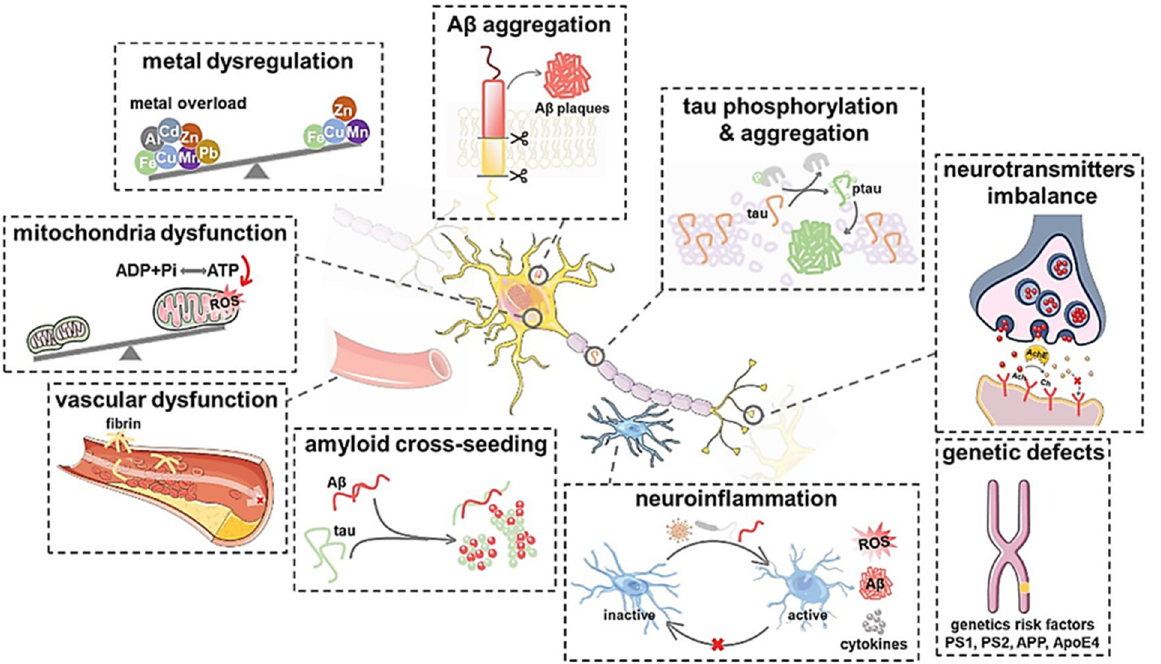
Figure 1. Different plausible Alzheimer’s disease mechanisms of A β aggregation, tau phosphoryla- tion and aggregation, neurotransmitters imbalance, genetic defects, neuroinflammation, amyloid cross-seeding, vascular dysfunction, mitochondria dysfunction, and metal dysregulation [31]. “Reprinted from [31] “A mechanistic survey of Alzheimer’s disease” Biophysical Chemistry 2022, 281, 106735, (2022), with permission from Elsevier”.